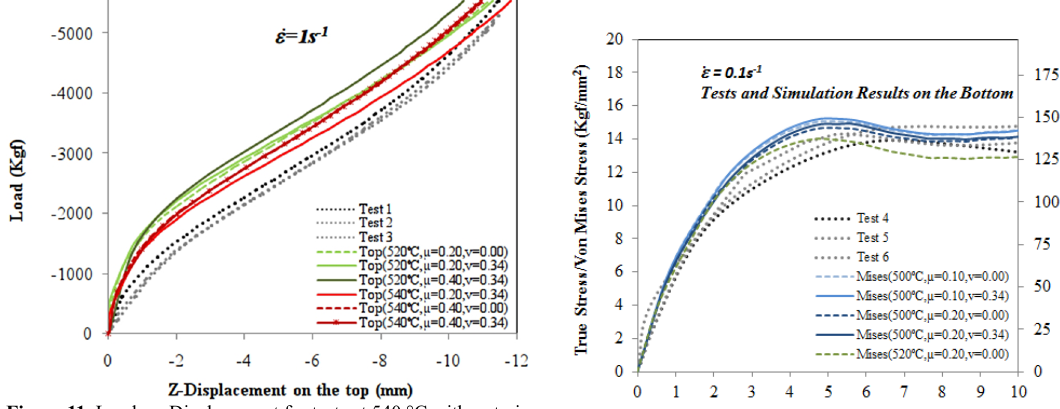
Figure 11. Load vs. Displacement for tests at 540 °C with a strain rate of 1 s -1 obtained from the experiments (dotted lines), and from the simulation (solid and dash lines).